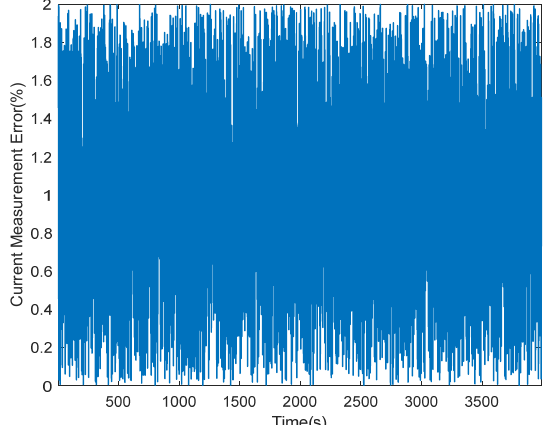
Figure 19. Current measurement error during dynamic current with disturbance.